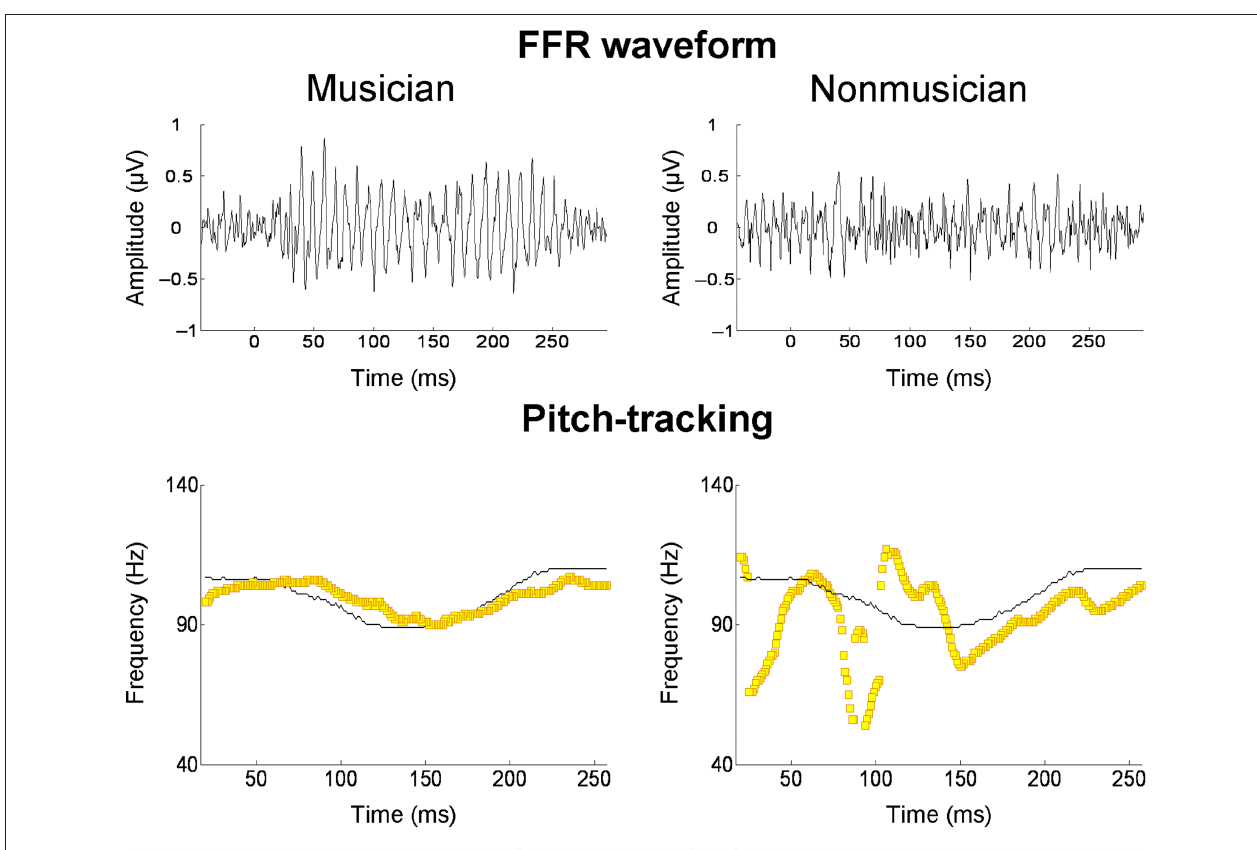
FiguRE 5 | Frequency-following responses to the spoken syllable /mi/ with a “dipping” (tone 3) pitch contour from Mandarin. The top row shows FFR waveforms of a musician and non-musician subject; the bottom row shows the fundamental frequency of the voice (thin black line) and the trajectories (yellow